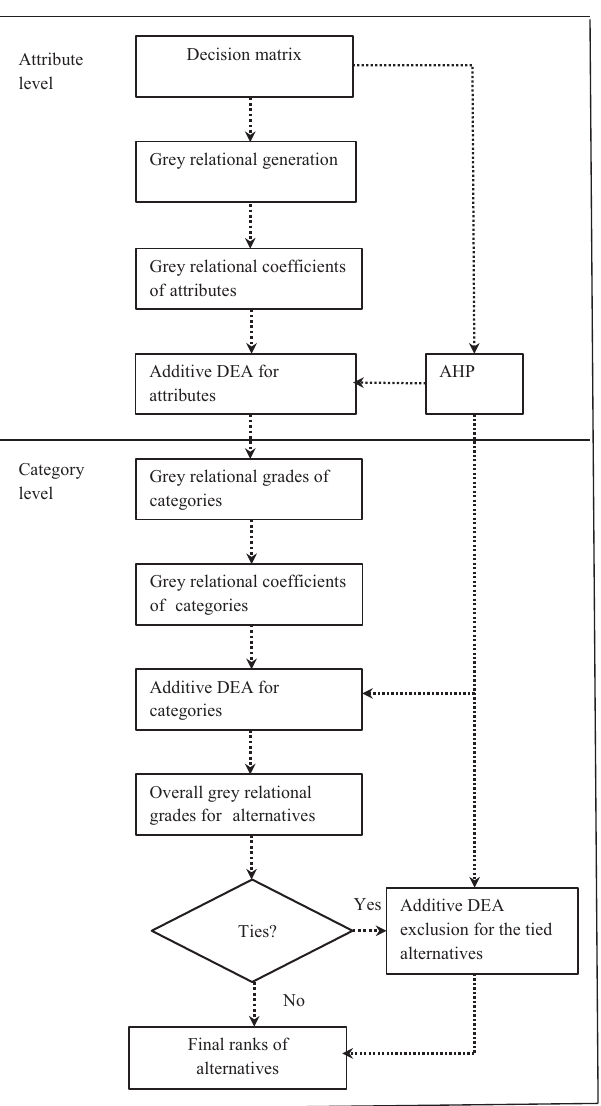
Figure 2. The fl owchart of a two-level hierarchy GRA using DEA and